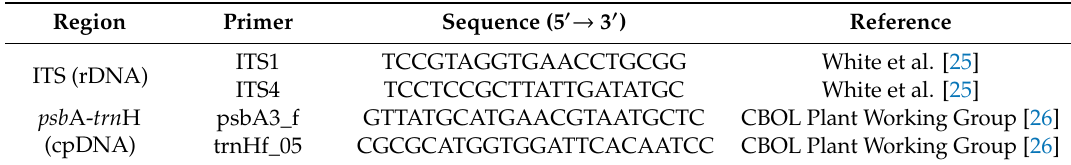
Table 2. Primer information applied for the present study.